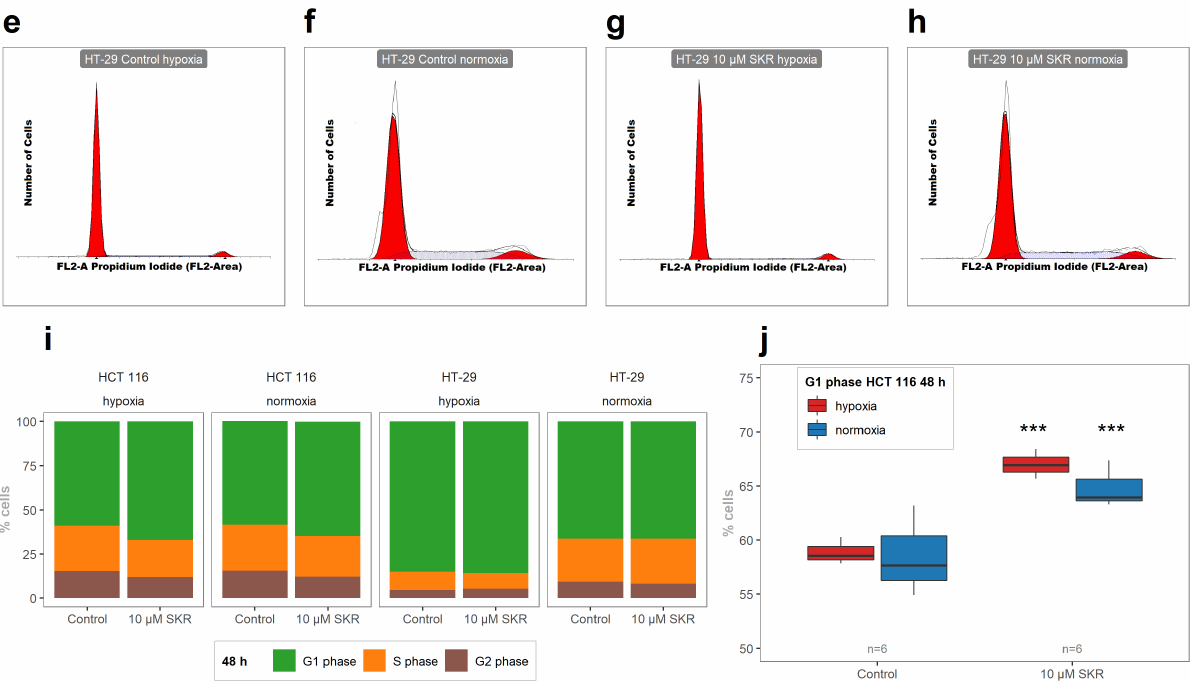
Figure 3. The effect of SKR on cell cycle distribution in cancer cell lines HCT 116 and HT-29. ( a – h ) Representative plots of cell cycle analysis after SKR treatment in HCT 116 and HT-29 cell lines. ( i ) Distributions of individual phases of the cell cycle analyzed after 48 h after treatment in HCT 116 and HT-29 cell line from at least three independent experiments. ( j ) Significant accumulation of HCT 116 cells in the G1 phase after 48 h after treatment with 10 µ M SKR. Control samples contain the same amount of DMSO as the sample with SKR. The results are expressed in boxplots or as averages in bar plots of three independent experiments. The experimental groups were compared with the control group. The number of samples (n) is noted in plots. (*** p <